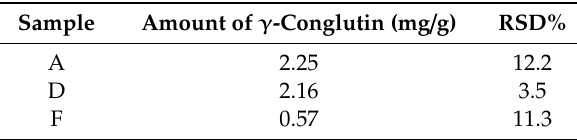
Figure 5. Extracted ion chromatograms of NIHKRTPL after mass spectrometry (MS) analysis in A, D, and F pasta samples. Table 2. Amount of γ -conglutin found in lupin-based